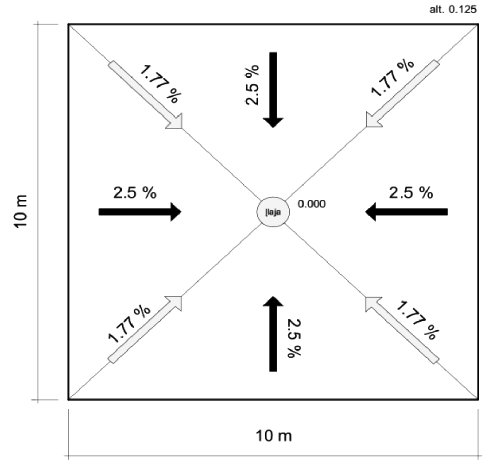
Fig. 11. The roof slopes model Fig. 12. Roof slope model, when the height of one or two opposite edges of the roof is limited